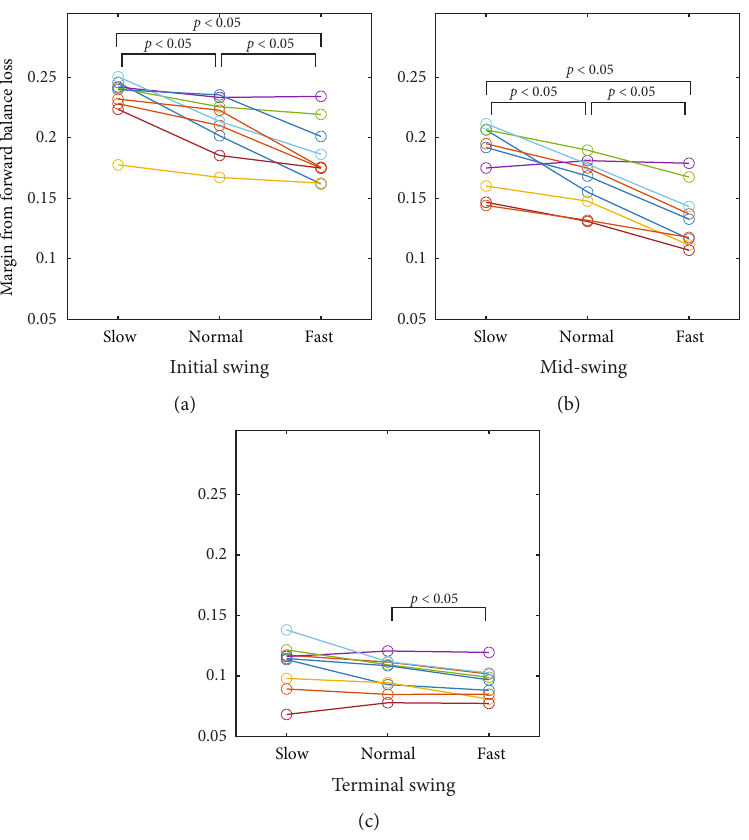
Figure 5: Margin from the forward balance loss of each participant at initial swing (a), midswing (b), and terminal swing (c).